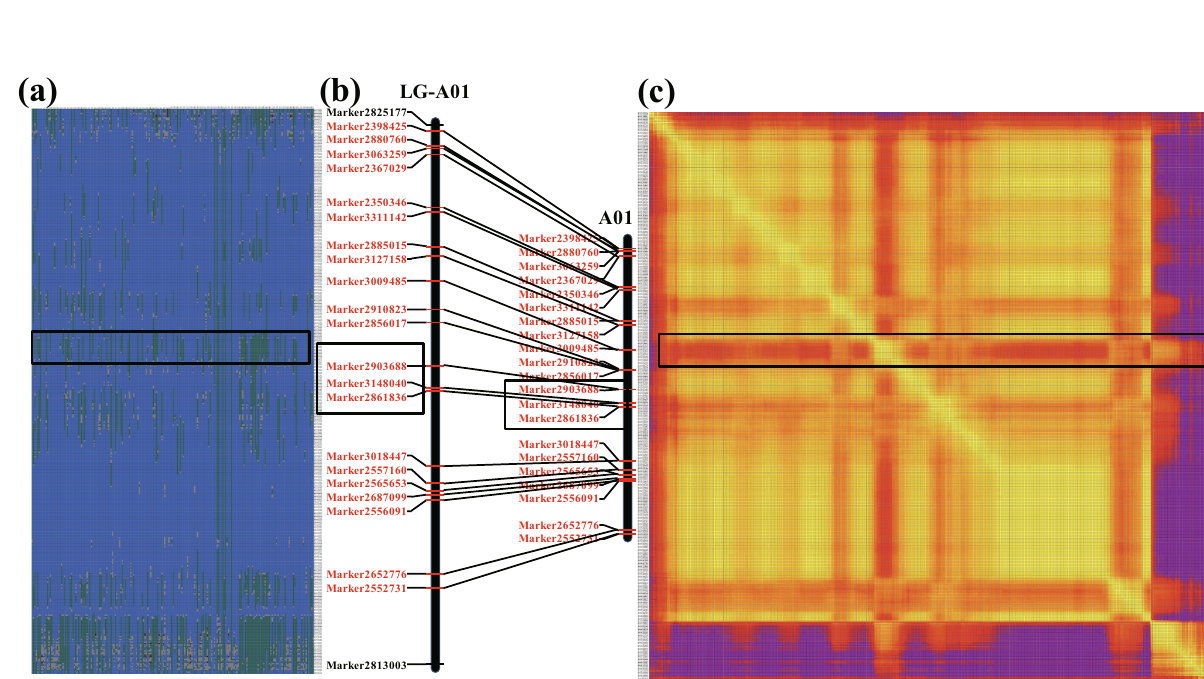
Figure 4. Recombination hot spots in the RIL (F 6 ) population. ( a ) Haplotype maps of SLAF markers in RIL (F 6 ) population; ( b ) co-linearity of recombination hot spots in genetic linkage map and physical map of RIL (F 6 ) population; ( c ) heat maps of SLAF markers in RIL (F 6 )